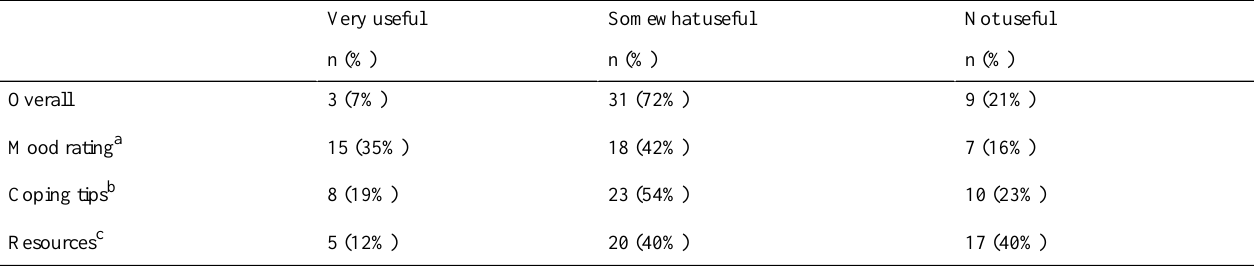
Table 1. Participants’usefulness ratings.